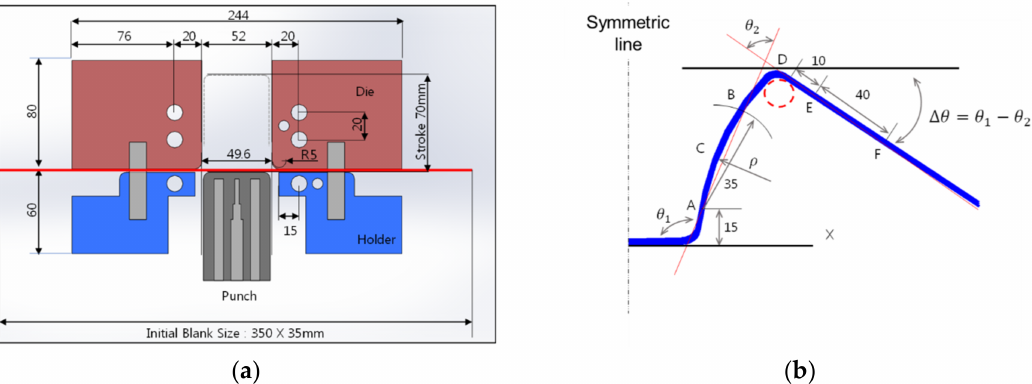
Figure 2. ( a ) A schematic illustration of the U draw-bending setup and ( b ) the amount of springback after the draw-bending test: ∆ θ (The blue thick line denotes the deformed